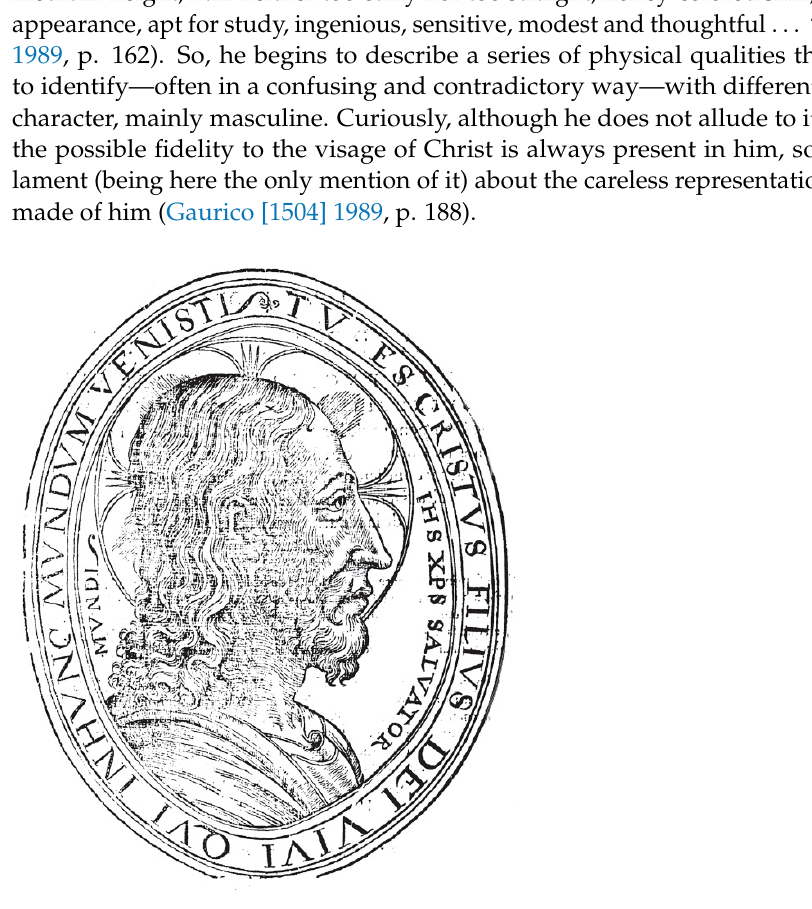
Figure 1. Anonymous. Rostro de Cristo . PHILIPPE DE SOSA, Libro de la Primera parte, de la excelencia del Sancto Evangelio …, n.p.